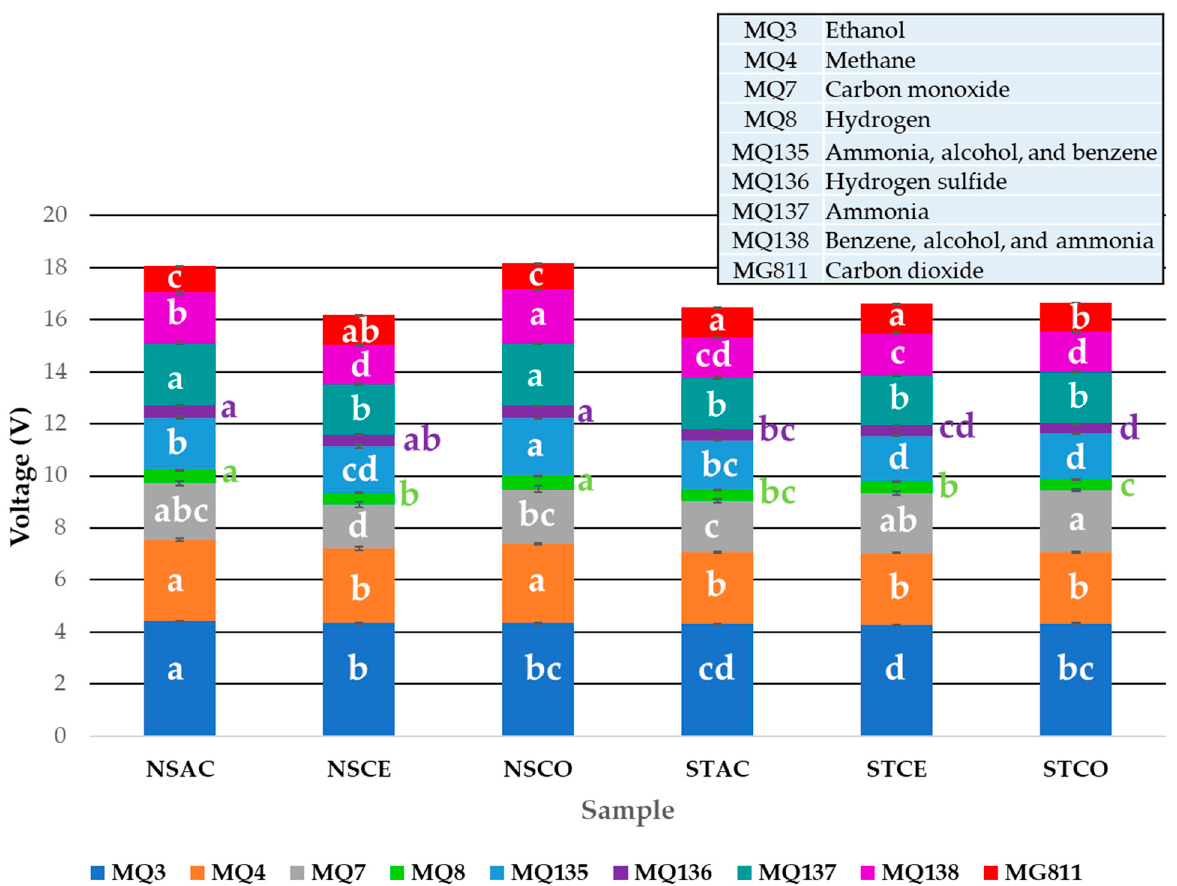
Figure 2. Stacked mean values of the electronic nose outputs showing the letters of significance from the ANOVA and Fisher’s least significant difference (LSD) post hoc test ( p < 0.05; α = 0.05). Differences between samples are compared for each sensor (bar colors). Abbreviations: NSAC: non-smoke-tainted wine with activated carbon treatment, NSCE = non-smoke-tainted wine with enzyme and activated carbon treatment, NSCO = control non-smoke-tainted wine, STAC = smoke-tainted wine with activated carbon treatment, STCE = smoke-tainted wine with enzyme and activated carbon treatment and STCO = control smoke-tainted wine.